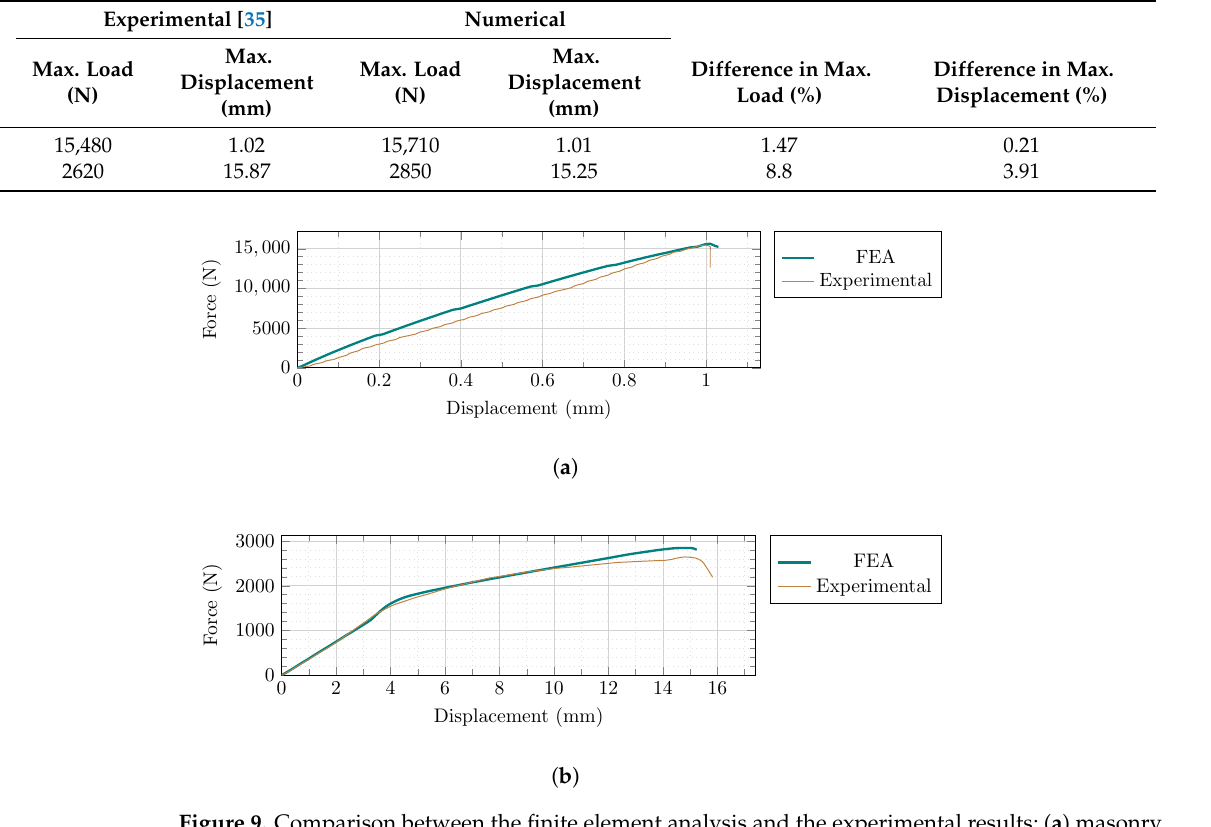
Table 6. Comparison between the finite element analysis and the experimental results.